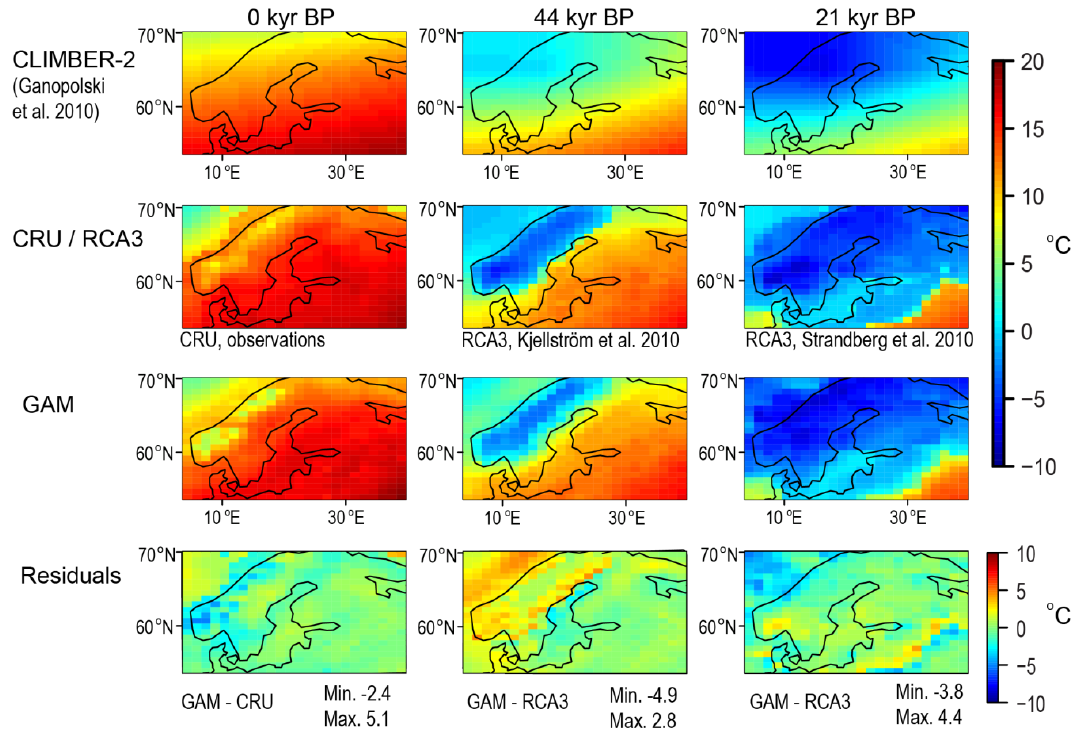
Figure 5. July mean temperature at 0 (left column), 44 (middle column) and 21kyr BP (right column) as simulated by the global model CLIMBER-2 (top row), as observed during the period 1961–1990 by the CRU (first panel of the second row), as simulated by the regional model RCA3 (second and third panels of the second row), as predicted by the GAM model (third row), and as the difference between the statistical model and observation/simulation (bottom row). The unit is degrees Celsius. The data of the first and the second rows have been bilinearly interpolated to a 1.5 ◦ × 0.75 ◦ resolution.